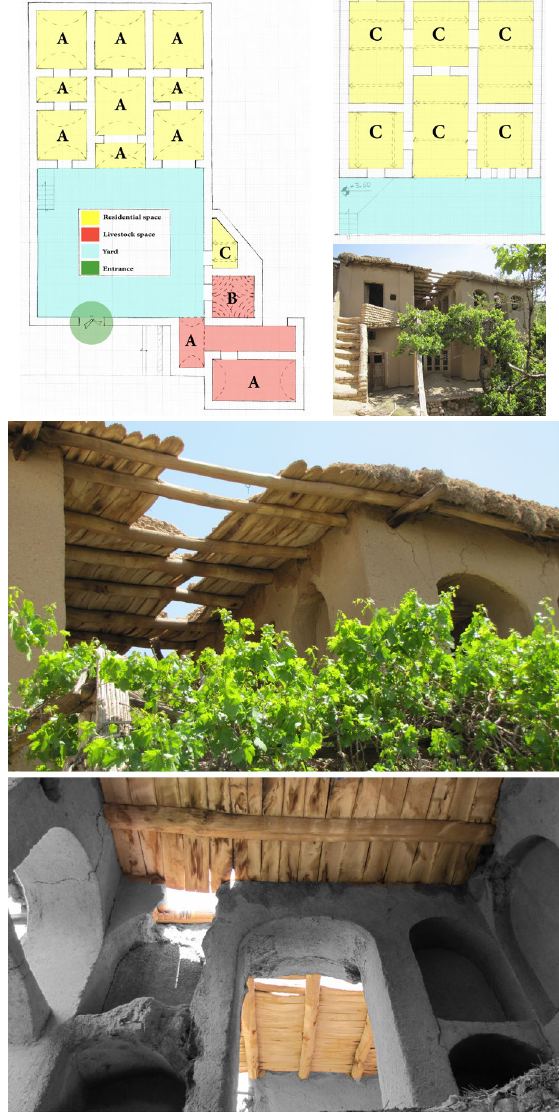
Figure 16. one examples of study houses in the third era, (A: Barrel vault, B: Chahar-dori vault, C: Takhte-Poosh),